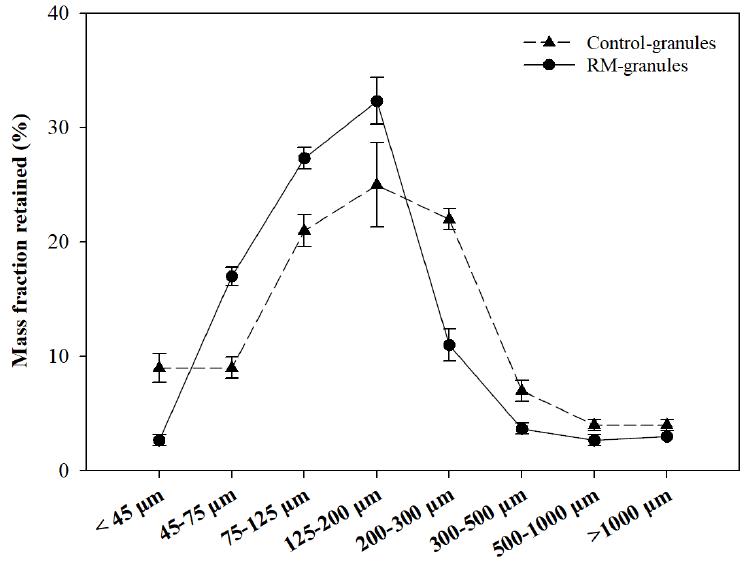
Figure 5. Particle size distribution of Control- and RM-granules based on mass fraction obtained by sieve analysis. Table 1. Diameters of Control- and RM-granules measured by sieve analysis.